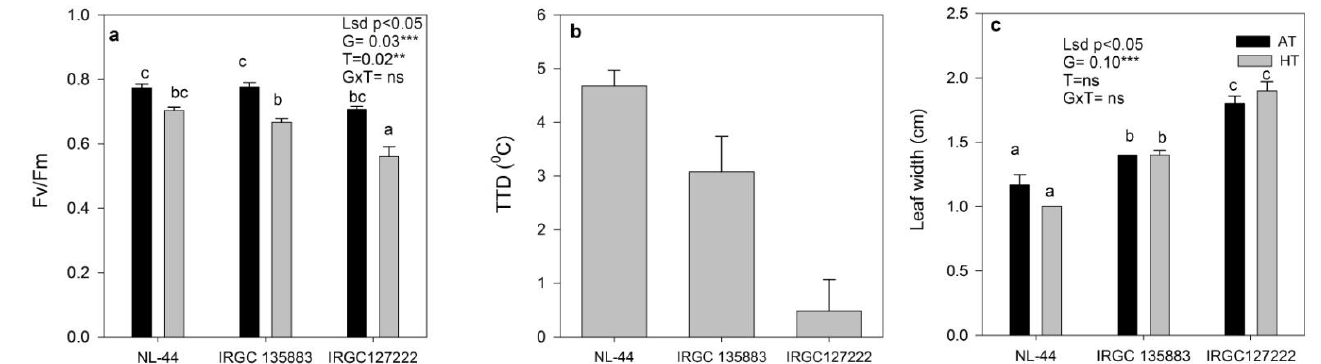
Figure 5. The effect of ambient-temperature (AT) and high-temperature (HT) exposure on ( a ) PS II efficiency (Fv/Fm), ( b ) tissue temperature depression (TTD) and ( c ) leaf width of contrasting rice accessions at the reproductive stage. Means of three replicates are indicated by the vertical columns in the figure. Error bars indicate the ± SEM. The least significant difference test was used to determine significance. Means with the different letters are significantly different at level: ** p < 0.01, *** p < 0.001, ns non-significant.